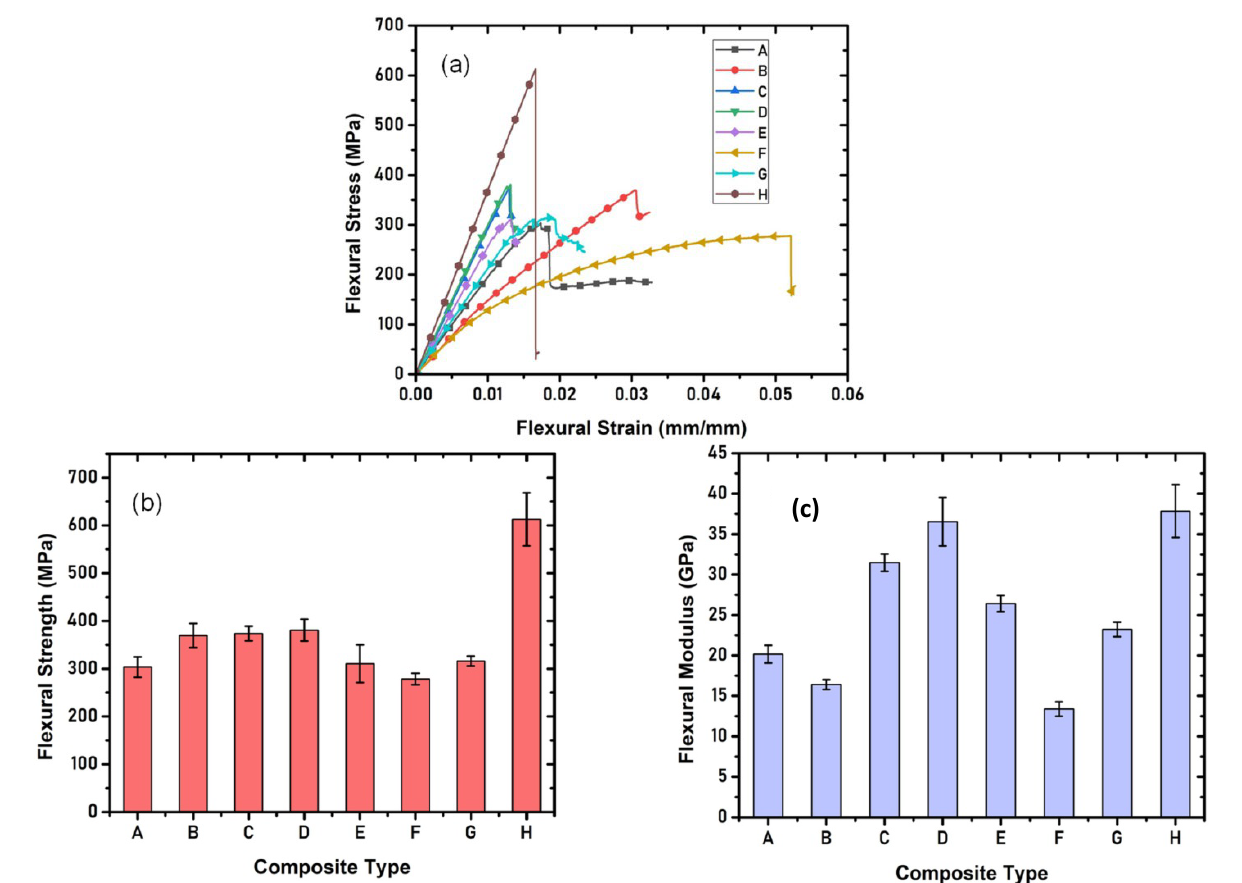
Figure 4. ( a ) Flexural strength versus strain, ( b ) Flexural strength, and ( c ) Flexural modulus versus composite type.